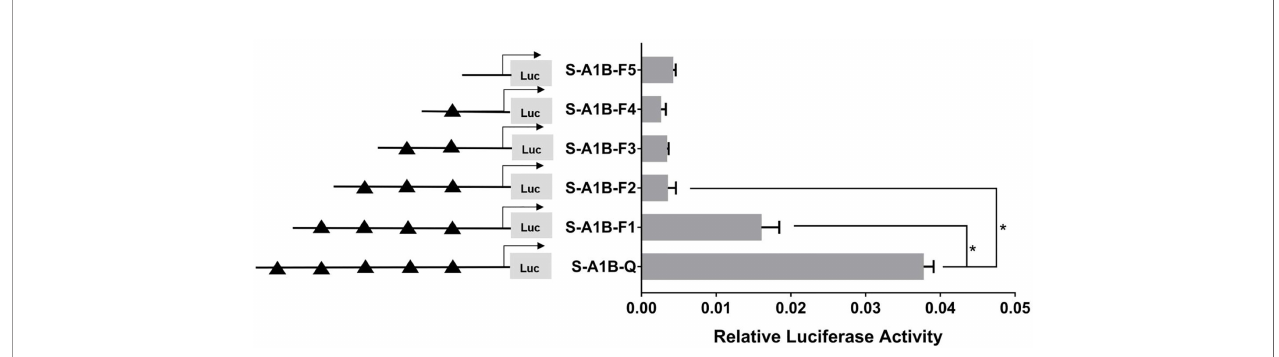
FIGURE 10 | Effect of SF-1 on the transcriptional activity of the cyp19a1b promoter fragment of the progressive deletion site. On the left is a schematic diagram of the promoter deletion and the triangle represents the binding site. The right side is the expression of luciferase in the promoter recombinant vector. S-A1B-F1 (-2379 bp to -1795 bp deletion), S-A1B-F2 (-2379 bp to -1534 bp deletion), S-A1B-F3 (-2379 bp to -1501 bp deletion), S-A1B-F4 (-2379 bp to -864 bp delettion), S-A1B- F5 (2379 bp to -504 bp deletion). The black triangle represents the SF-1 binding site. One-way ANOVA was performed on the data and expressed as mean ± standard deviation (n = 4). *There is a signi fi cant difference between the